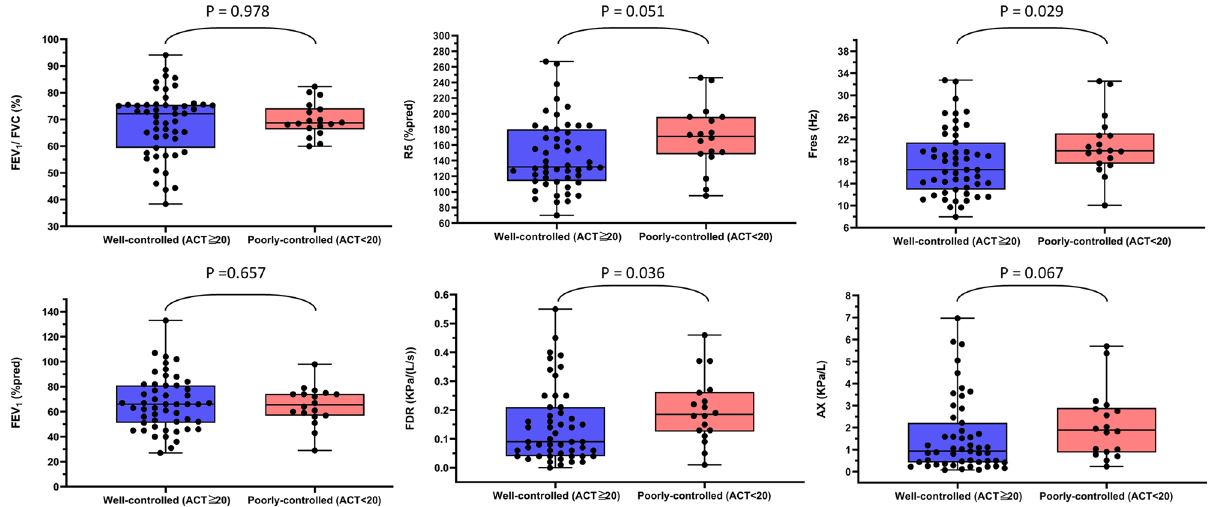
Figure 2. Differences in parameters of spirometry and IOS between well- and poorly-controlled asthma. Abbreviation ACT, asthma control test; AX, reactance area; FDR, frequency-dependent resistance; difference in resistance at 5 Hz and 20 Hz; FEV 1 , forced expiratory volume in 1 s; F res , resonance frequency; FVC, forced vital capacity; R 5 %pred, predicted percentage of resistance at 5 Hz.